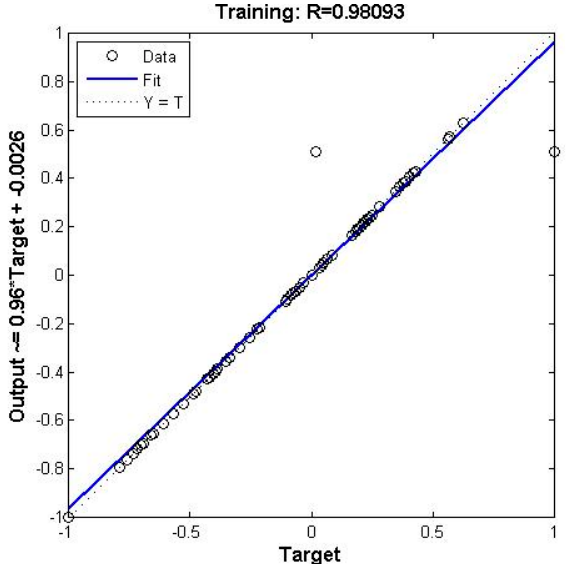
Figure 9. The regression fitting curve of GA-BPNN.